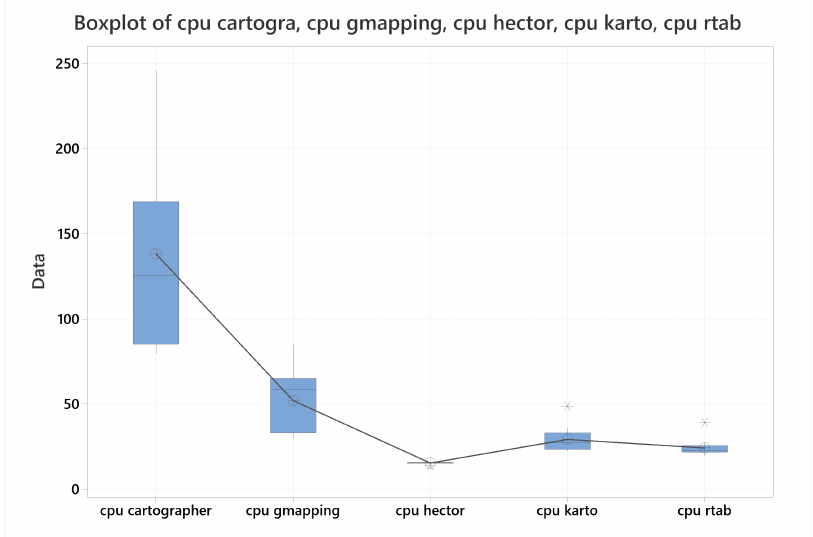
Figure 32. Boxplot for CPU usage with all the algorithms together. The data used for this section can be referenced in the Table 13. Table 13. Observation means for CPU